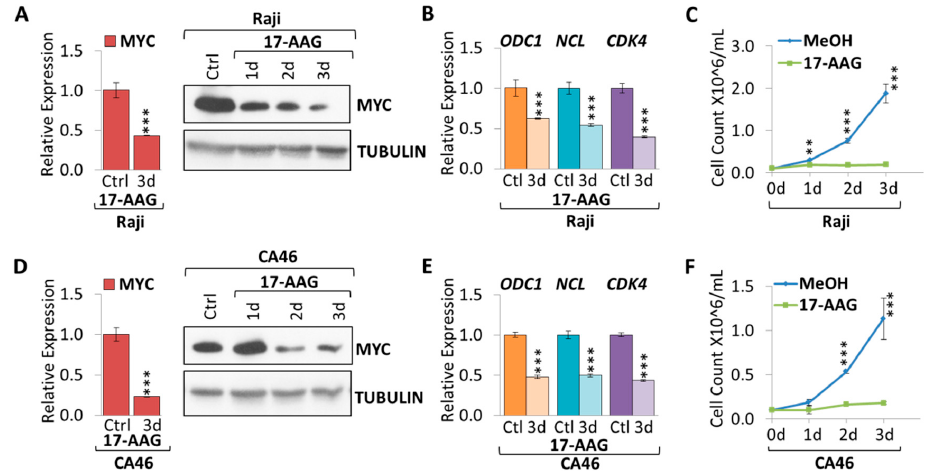
Figure 1. 17-AAG treatment suppresses MYC in Burkitt lymphoma. RT-qPCR and Western Blot (WB) of MYC expression upon 4 µ M 17-AAG treatment over the course of three days in ( A ) Raji and ( D ) CA46 cell lines. RT-qPCR of canonical MYC target genes: ODC1 , NCL , and CDK4 in ( B ) Raji and ( E ) CA46 cell lines upon three days treatment of 4 µ M 17-AAG or MeOH. Growth curve of cells treated with MeOH or 4 µ M 17-AAG over the course of three days in ( C ) Raji and ( F ) CA46 cell lines. RT-qPCR was normalized to RPL13a ; Tubulin is used as a WB loading control. Error bars represent mean ± SEM; n = 3; two-tailed Student’s t -test: * p < 0.05; ** p < 0.01; *** p < 0.001.